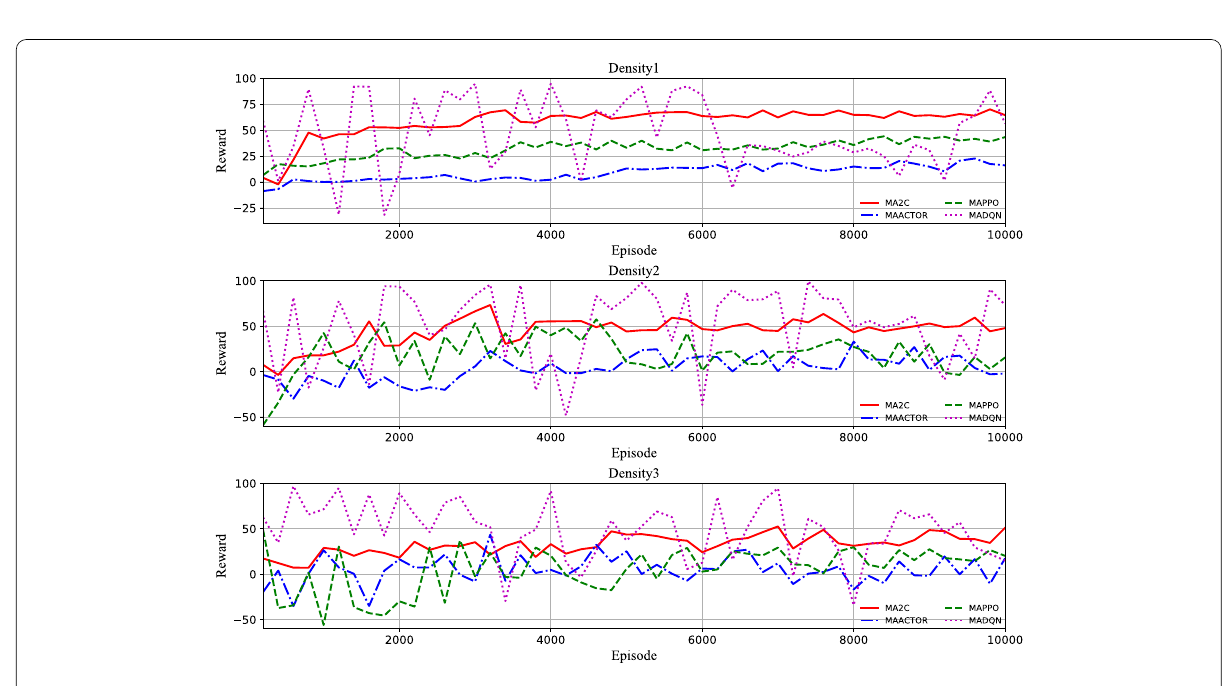
Figure 7 Performance comparisons on accumulated rewards in MADQN, MA2C, MAACKTR, and